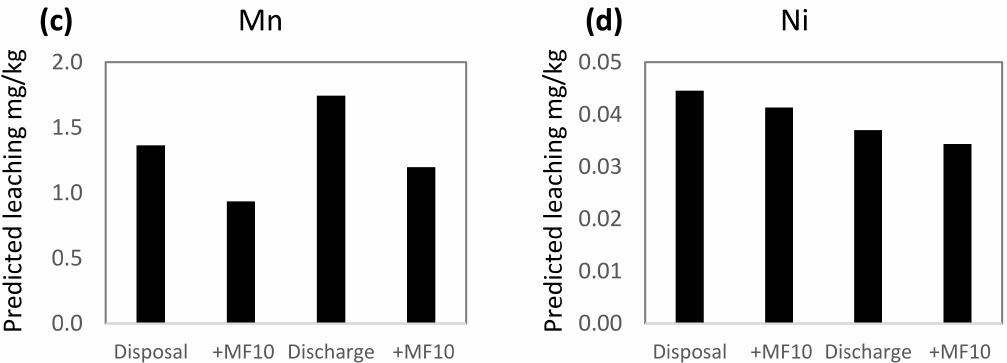
Figure 3. PLS predicted leaching of ( a ) Ba, ( b ) Cu, ( c ) Mn and ( d ) Ni in two different scenarios: disposal (no stirring, anoxic) and resuspension (stirring, aerated) in the Repparfjord. The prediction of metal leaching with the addition of Magnafloc10 is given for each of the scenarios (+MF10). For the prediction of leaching, the following settings were used: salinity 33.0 ppt, pH 8.02, temperature 4.5 ◦ C and DOC 1.6 mg/L, representing average conditions in the